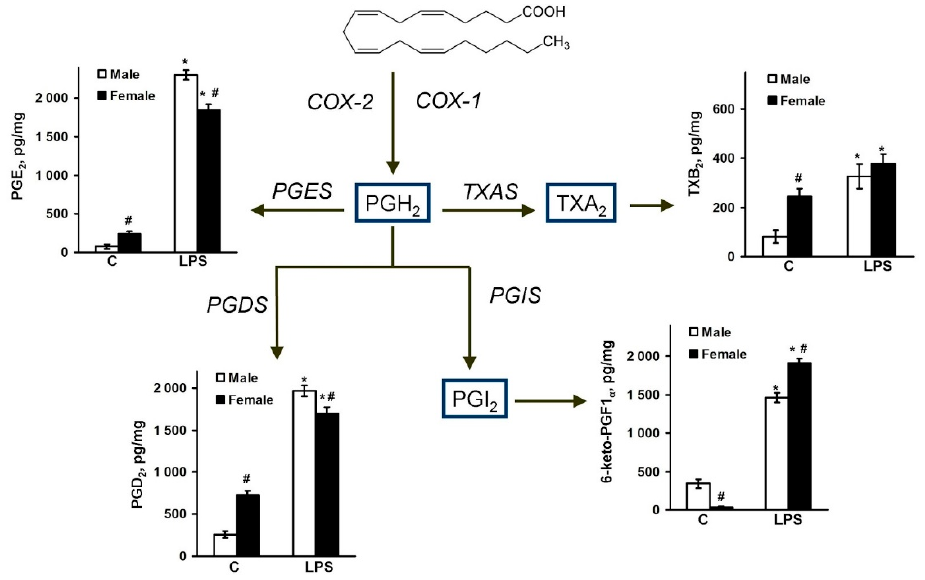
Figure 3. Sex differences in PGE 2 , PGD 2 , TXB 2 , and 6-keto-PGF 1 α releases after LPS-induced